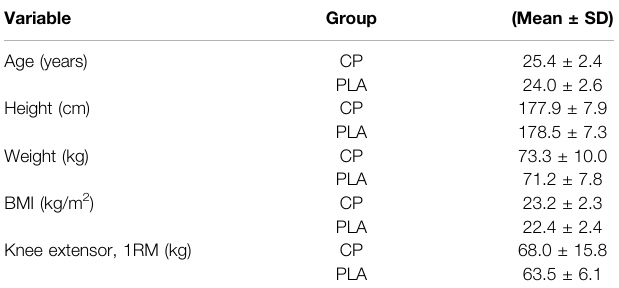
TABLE 2 | Baseline anthropometric characteristics (CP/PLA n =